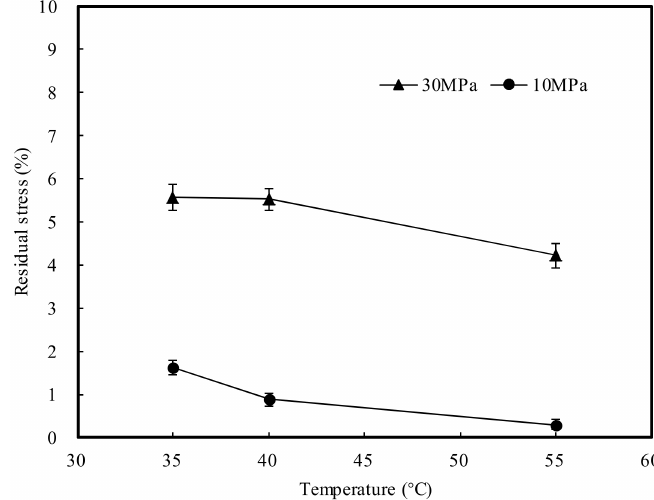
Figure 8. Effects of pressure and temperature on residual